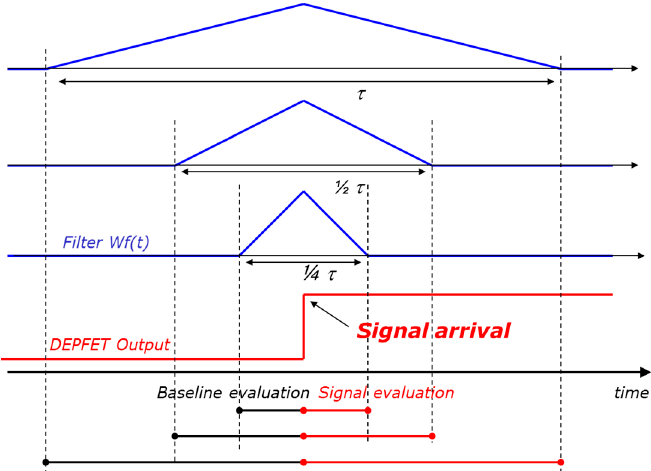
Figure 5. The same signal (red line) is processed by three triangular weighing functions with three different shaping times. The ENC component due to the white voltage noise goes down as the shaping time increases, while the ENC component related to the 1/f noise stays constant. Increasing the shaping time the ENC goes down up to the point in which it is dominated by the 1/f noise. A further increase of the shaping time would not provide any benefit.